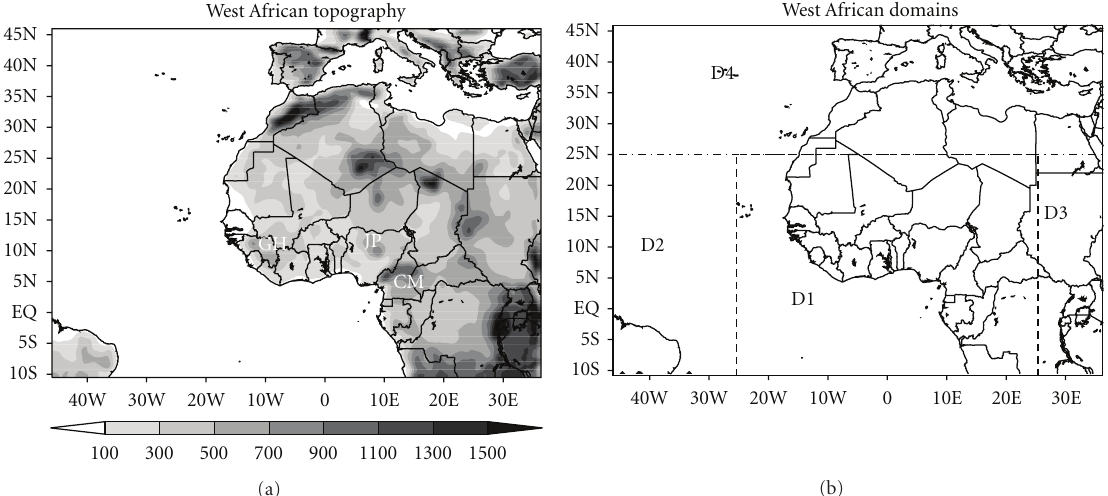
Figure 1: (a) The West African domain sizes and (b) topography (in meters). The analyzed domain for quantitative assessment extends from 20 ◦ W to 20 ◦ E and 0 to 20 ◦ N in red. The highlands are highlighted by their respective acronyms: Guinea Highlands (GH), Jos Plateau (JP), Cameroun Mountains (CM), and Sudanese Highlands